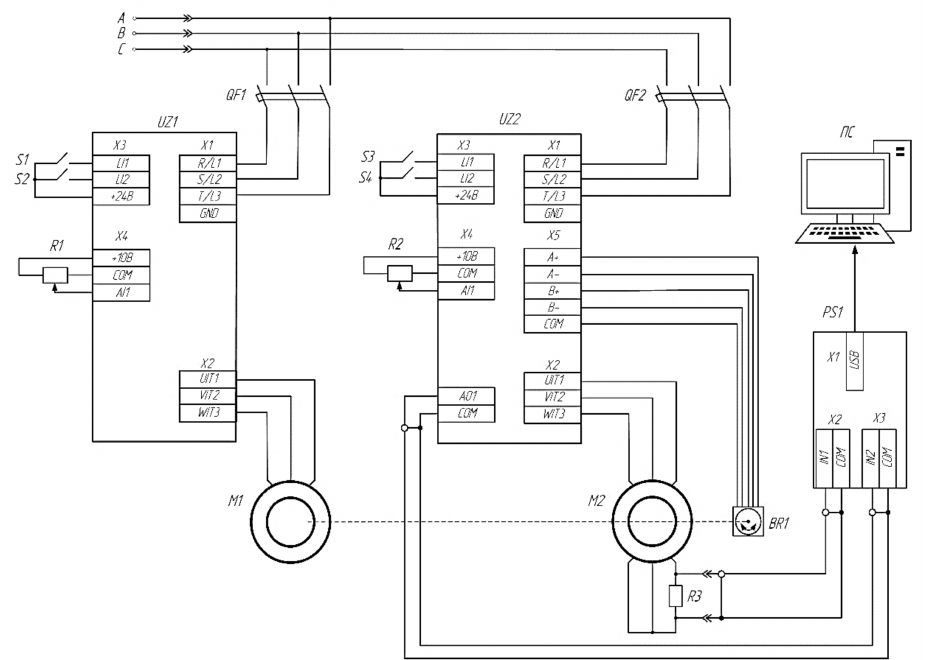
Figure 1. Electrical diagram of the stand.